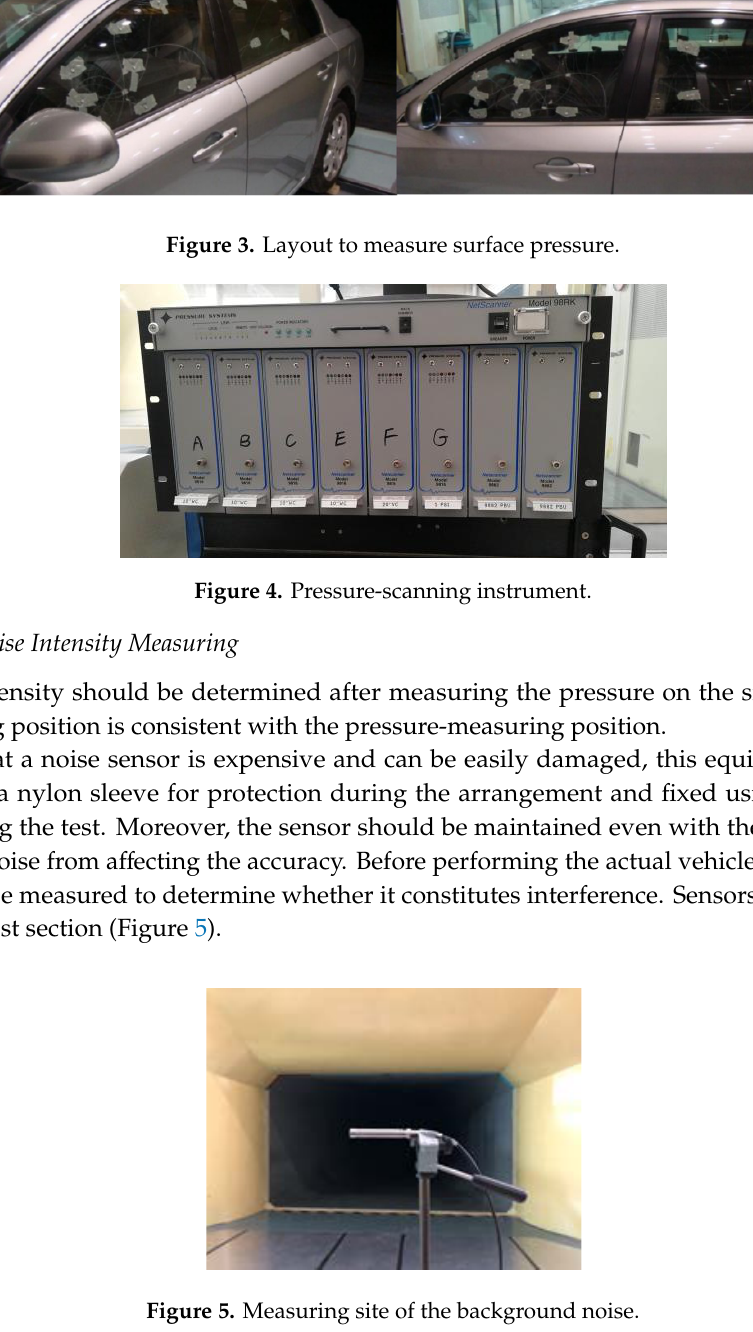
Figure 3. Layout to measure surface pressure.